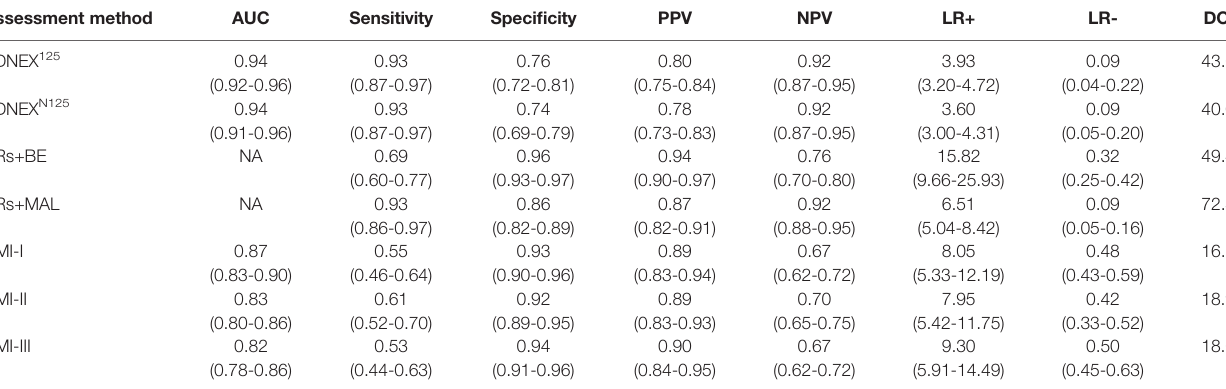
TABLE 3 | Diagnostic performance of the prediction models for discrimination between benign and malignant adnexal masses. Assessment method